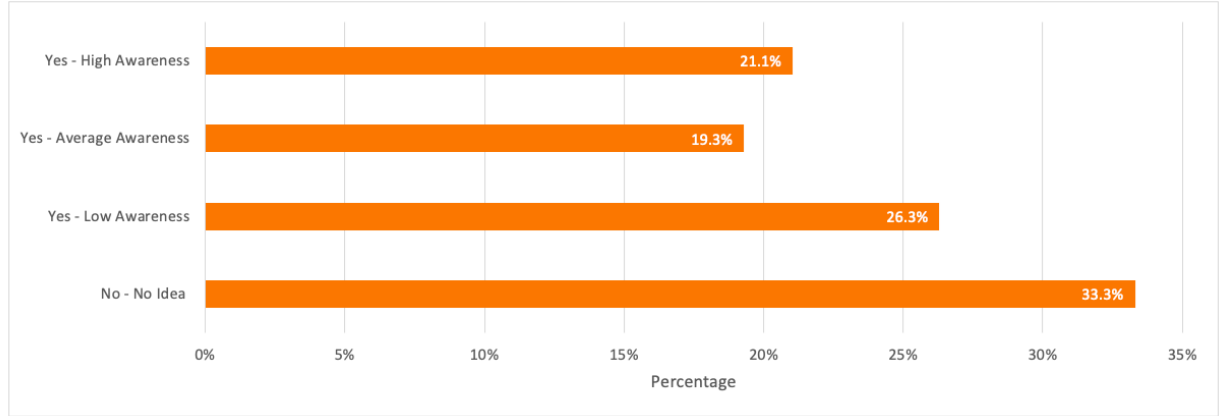
Figure 3. Respondents’ awareness of the concept of electronic waste (e-waste).